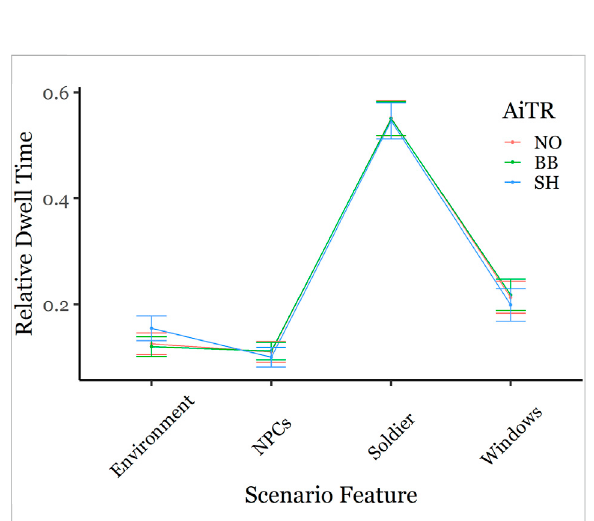
FIGURE 3 Mean Relative Dwell Time on LFDM Scenario Features